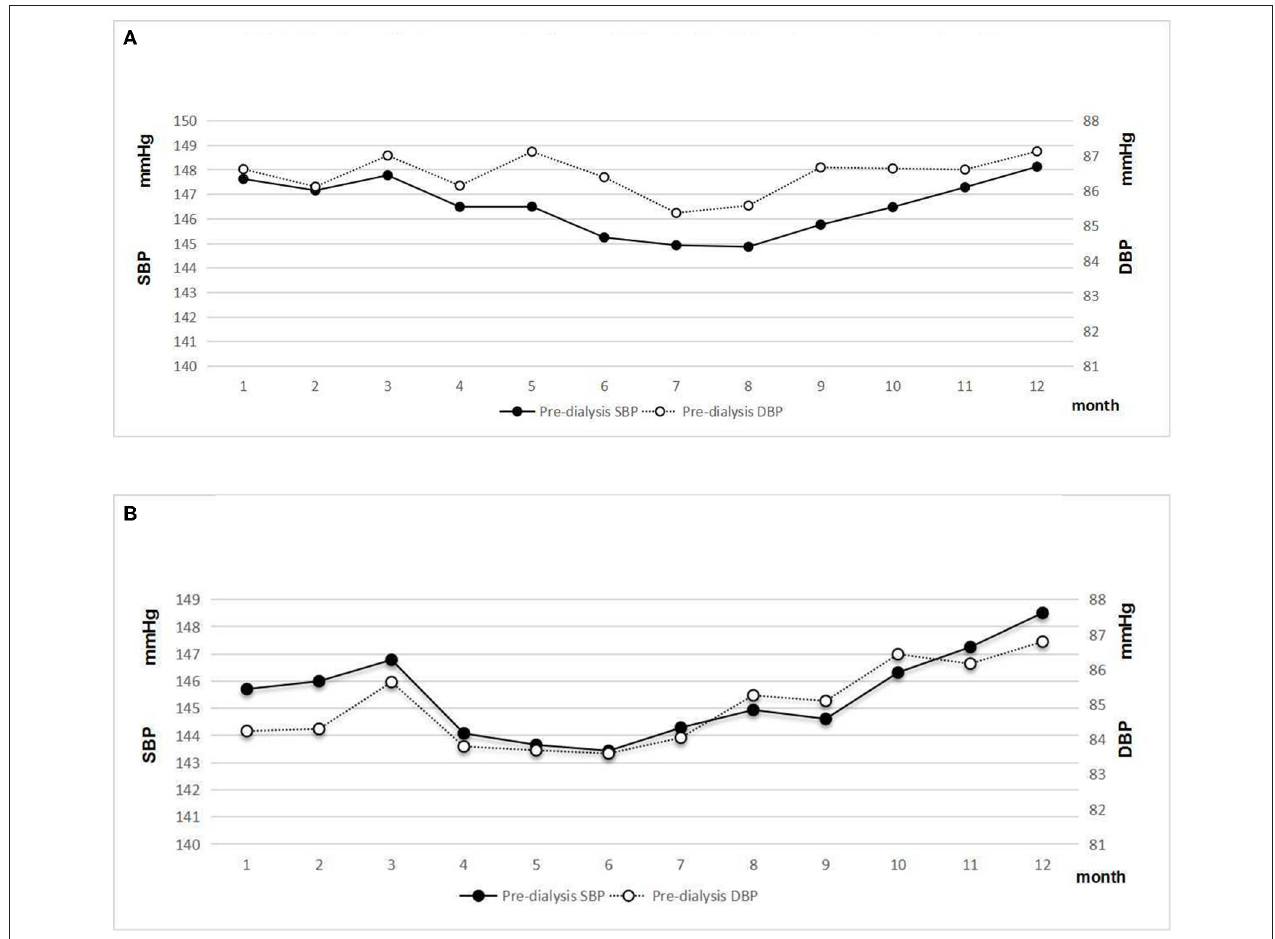
FIGURE 4 | (A) Pre-dialysis systolic and diastolic blood pressure of male patients. (B) Pre-dialysis systolic and diastolic blood pressure of female patients.